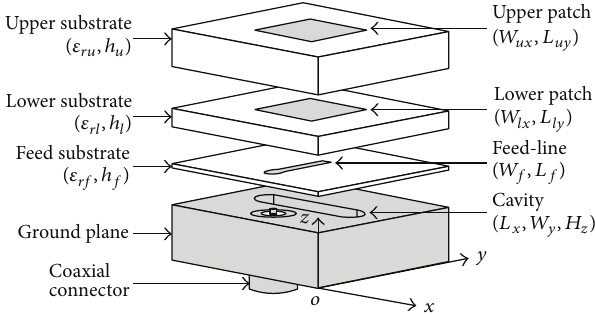
Figure 2: Geometry of the antenna element.